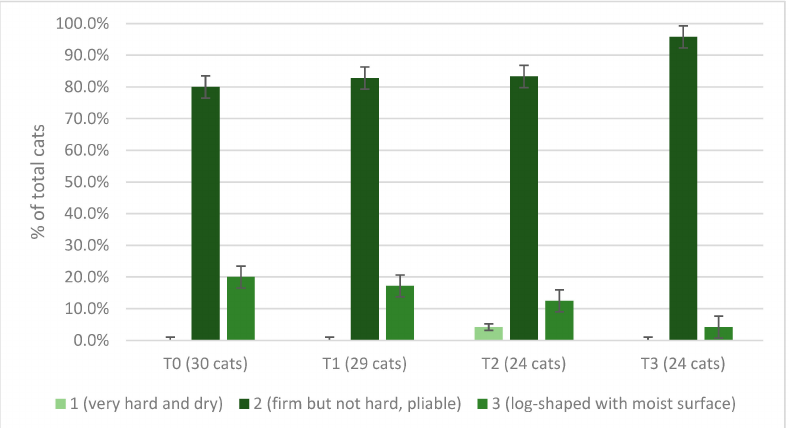
Figure 5. Fecal score of cats according to owners at T0, T1, T2, and T3 (no owner reported a fecal score higher than